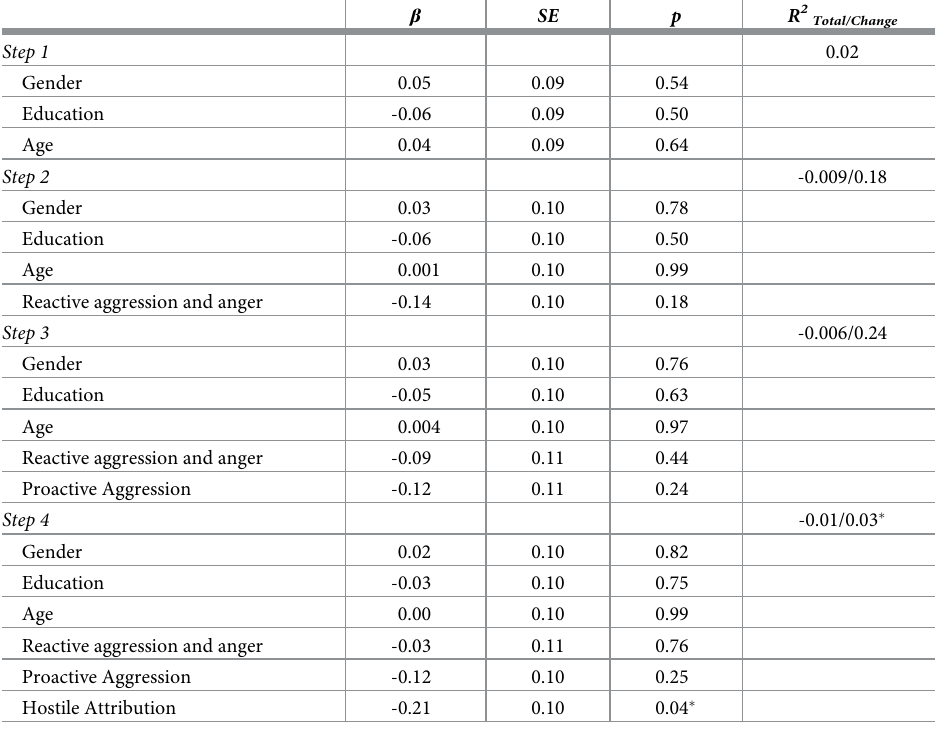
Table 4. Hierarchical multiple linear regression analysis predicting attentional bias away from neutral faces whilst holding an angry face in WM (BS2 NEGATIVE ). β SE p R 2